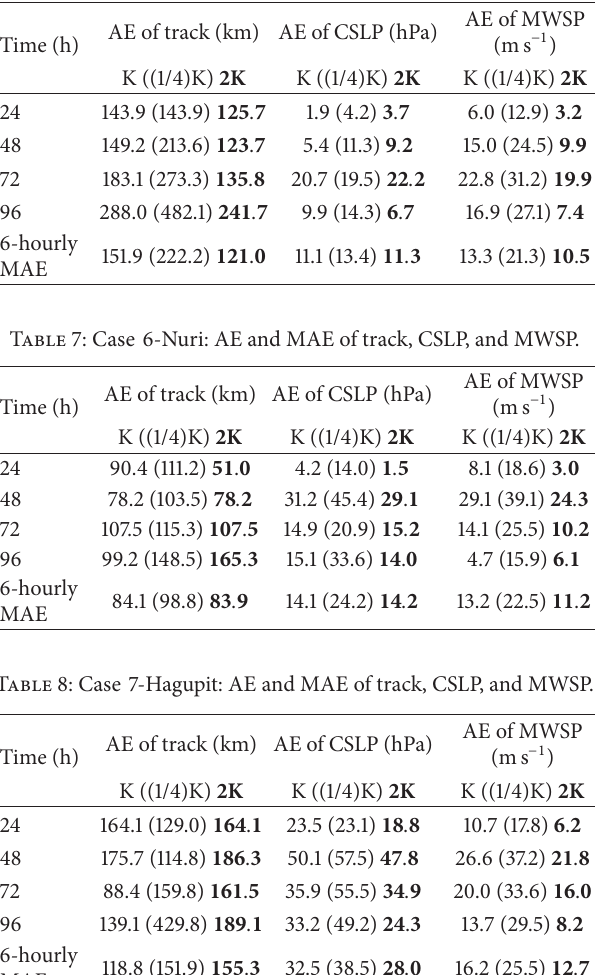
Table 6: Case 5-Vongfong: AE and MAE of track, CSLP, and MWSP.